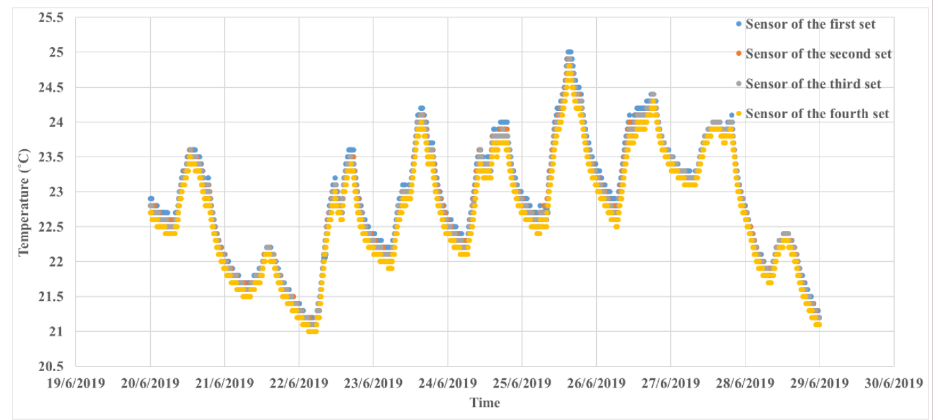
Figure 3. Recorded data by groups of sensors located at the same position.